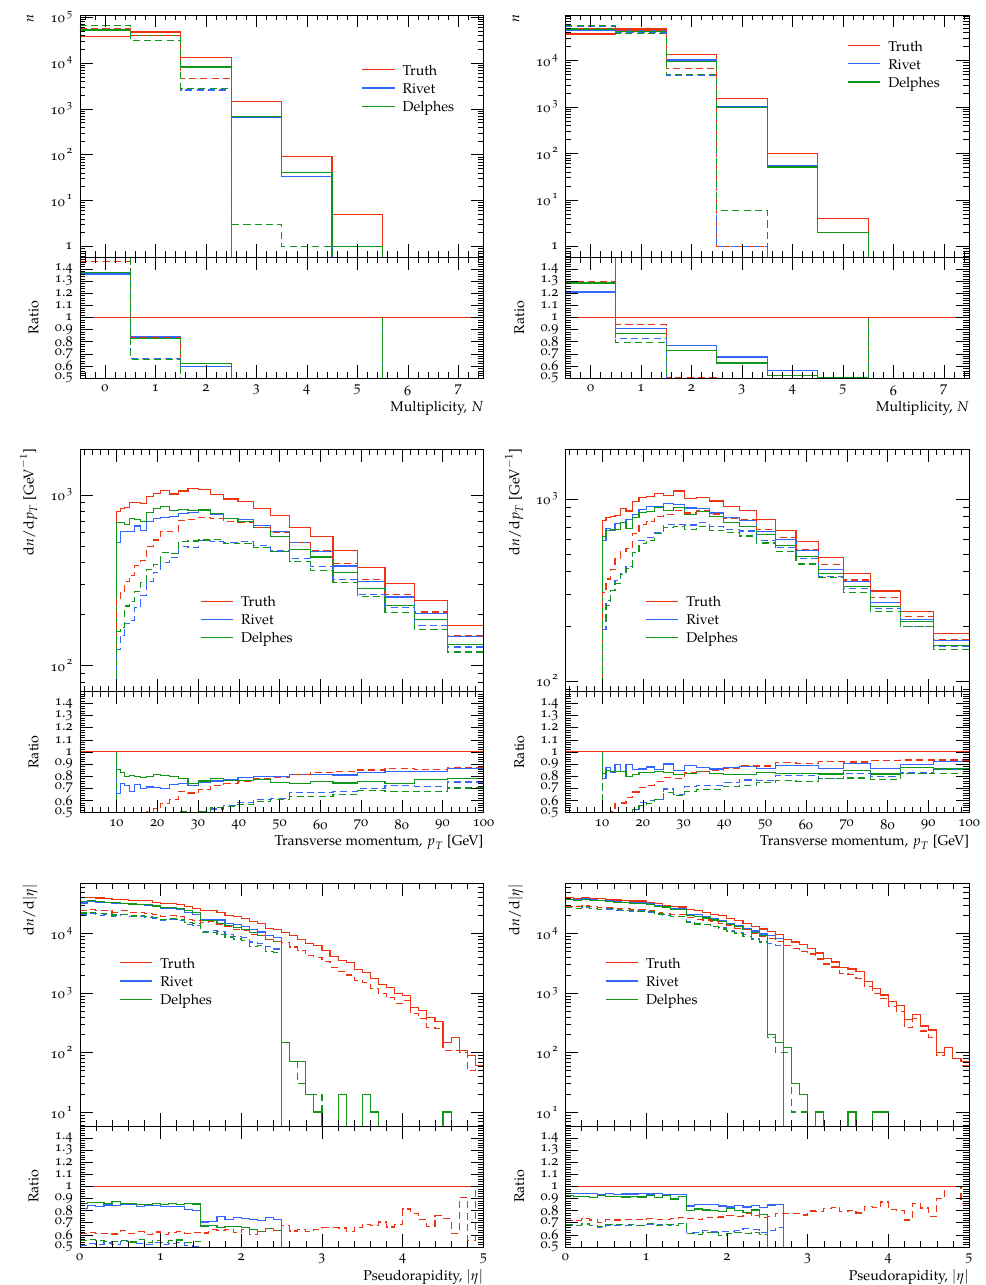
Figure 2: Electron and muon performance from Pythia8 LHC t ¯ t production at truth level, and after processing through the standard ATLAS detector emulation routines in R IVET and D ELPHES . Electron observables are shown in the left column, and muons in the right; the observables are multiplicity, p distribution, and | η | distribution from T top to